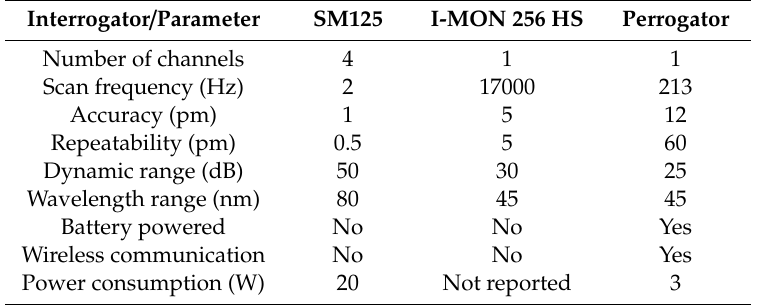
Table 3. Comparative characteristics between commercial interrogators and Perrogator.